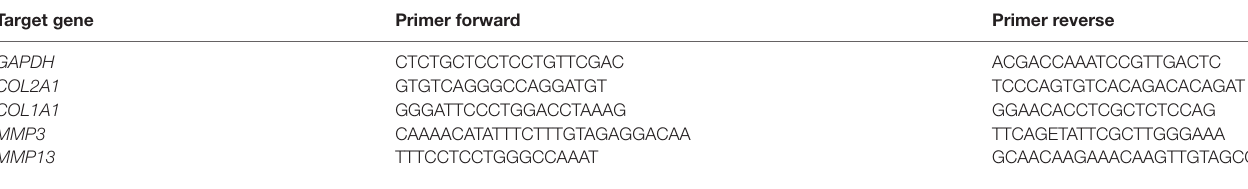
Table 1 | Sequences of primers and conditions used in reverse transcriptase quantitative real-time PCR. Target